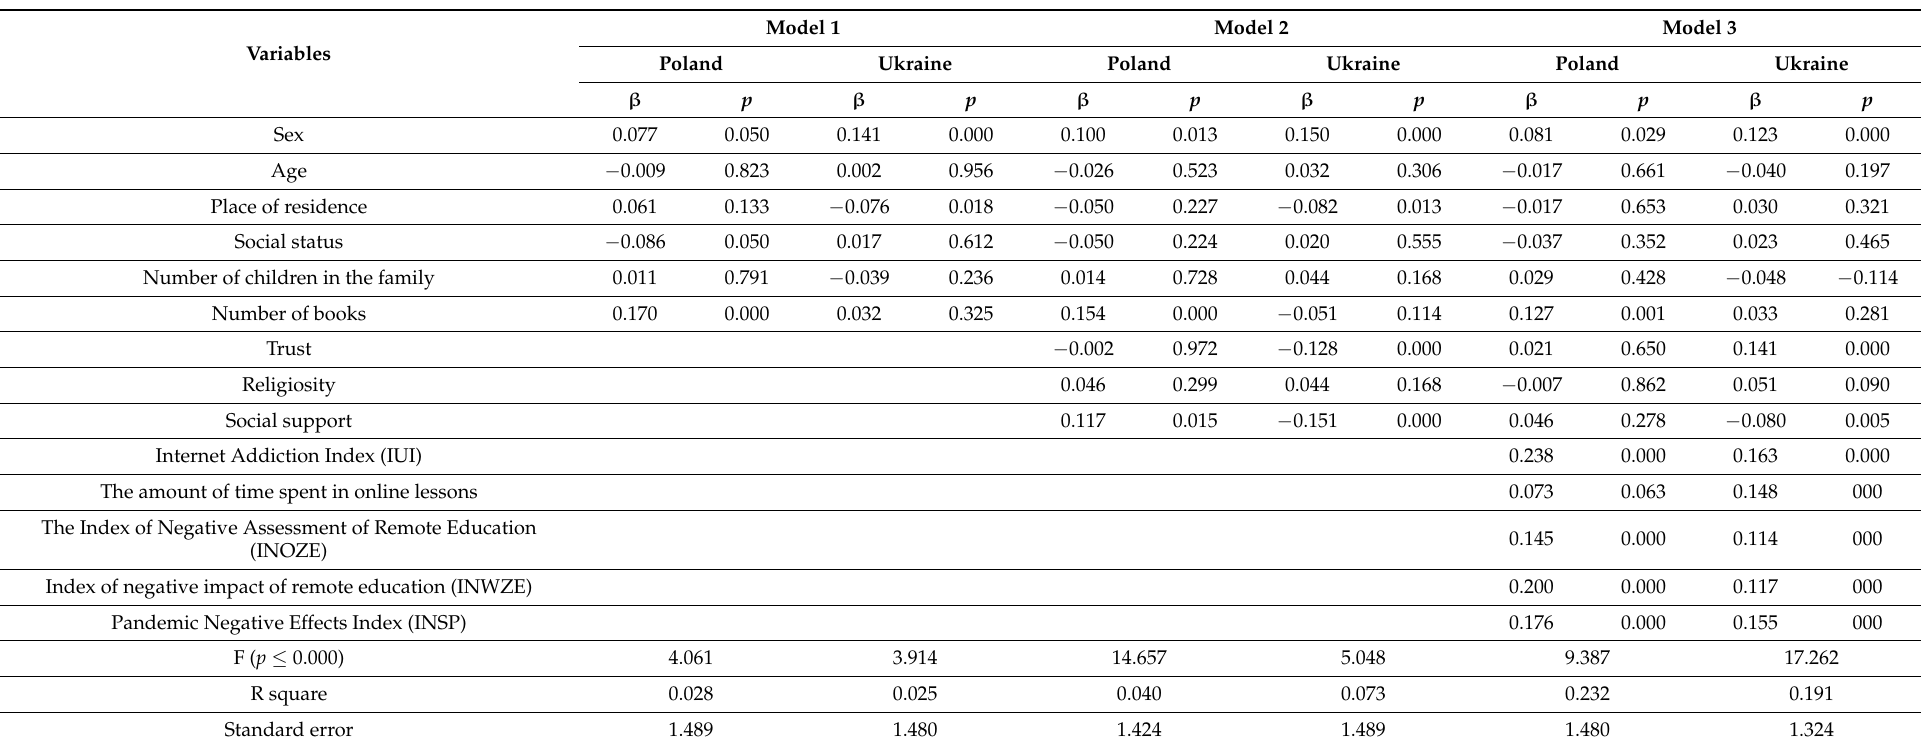
Table 6. Results of multiple regression analyzes predicting the health burdens during remote